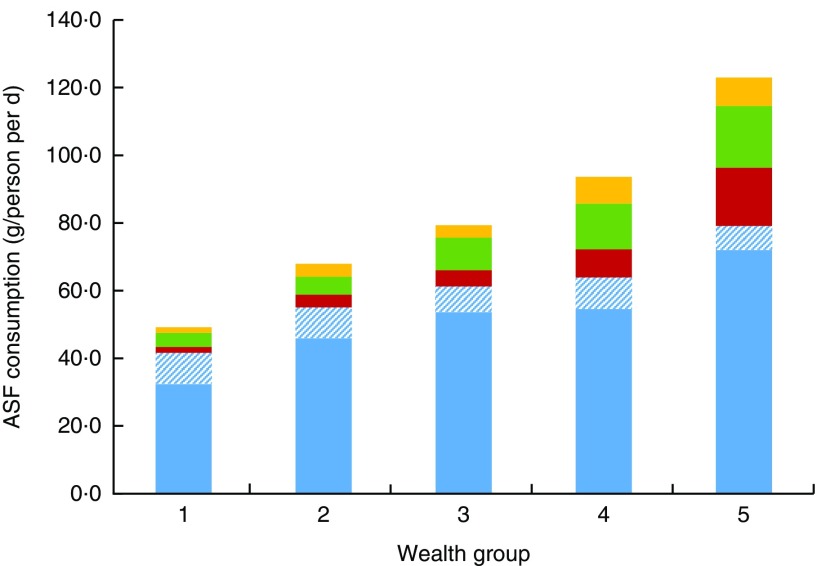
(colour online) Mean consumption (g/person per d) of animal-source foods (ASF;
, fresh fish; ,
dried fish*; , meat; ,
poultry; , eggs) by wealth group† in rural
Bangladesh (adjusted for age, sex and geographic region), October 2011–March 2012.
*Dried fish includes fermented and dried fish, adjusted to fresh weight equivalent.
†Wealth group 1 represents the poorest 20 % of households and wealth group 5
represents the wealthiest 20 % of households